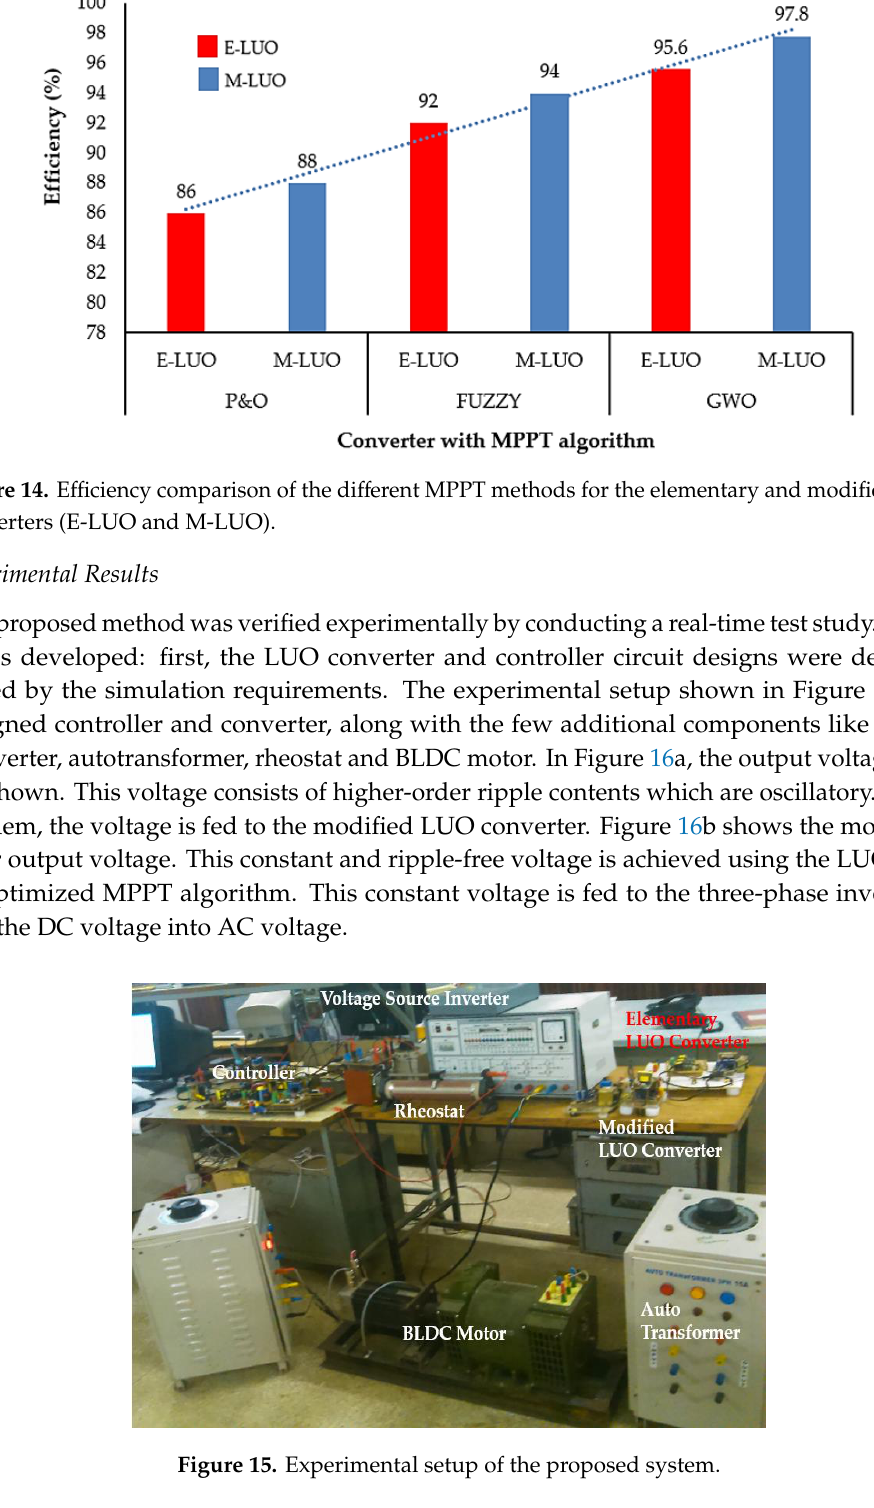
Figure 13. Output voltage comparison of different MPPT methods for the elementary and modified LUO converters (E-LUO and M-LUO).